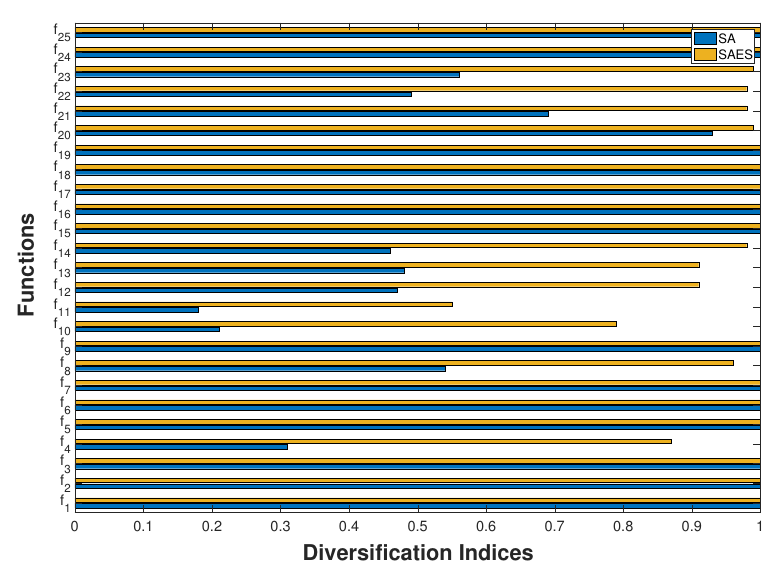
Figure 5. Diversification indices of classical test functions.